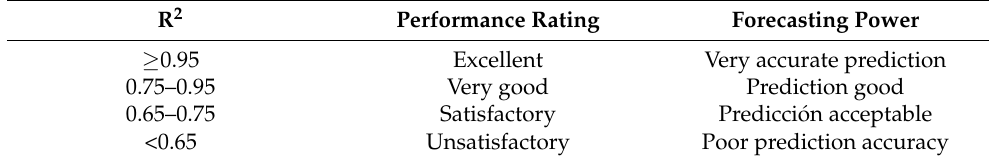
Table 4. Statistical criteria for R 2